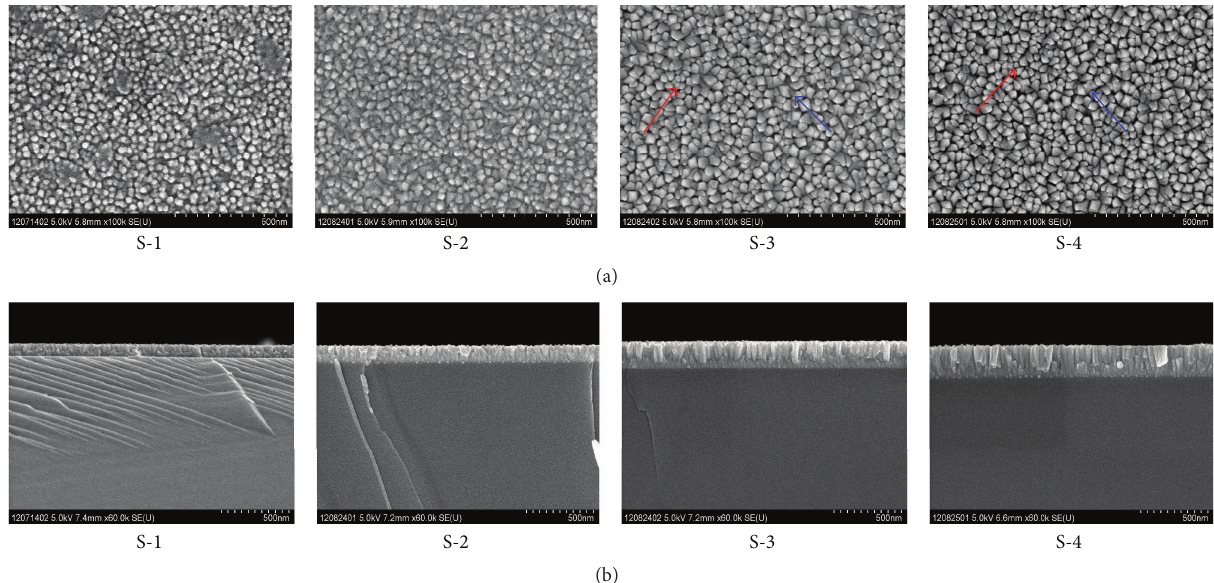
Figure 3: SEM images of the surface of the Al-doped CdO thin films: (a) S-1, S-2, S-3, and S-4 groups and cross-sectional SEM images; (b) S-1, S-2, S-3, and S-4 groups.